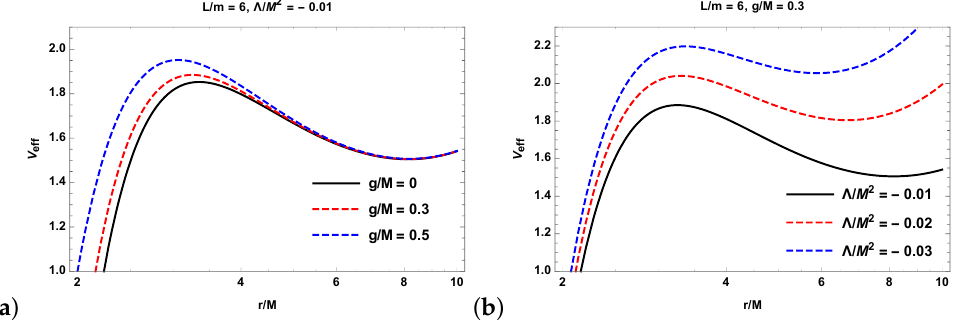
Figure 3. The radial dependence of the effective potential of a test particle around static regular Bardeen black hole in Anti-de Sitter spacetime. ( a ) for the fixed cosmological constant and various values of g and ( b ) for the fixed g and different Λ